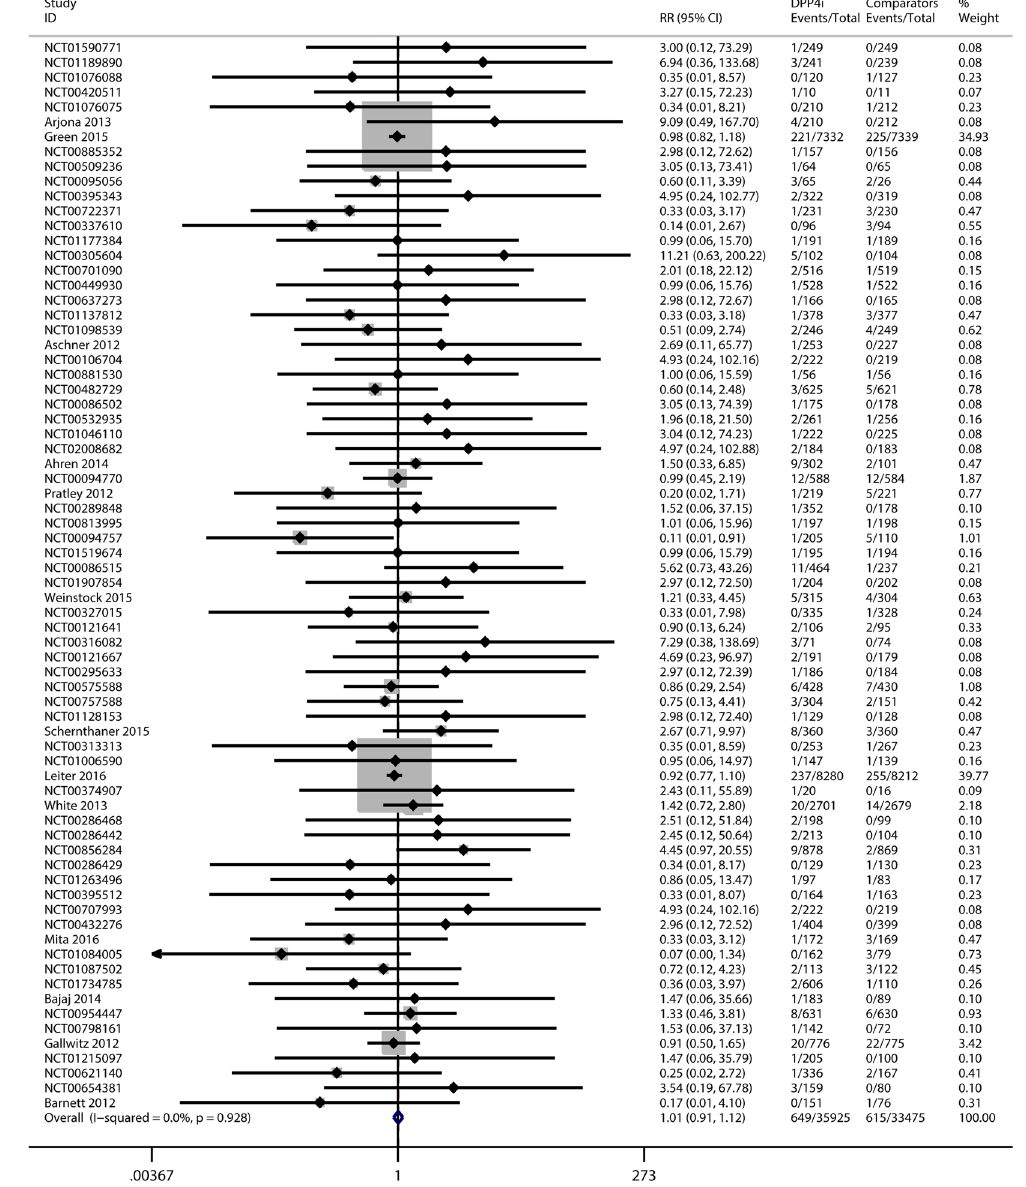
Figure 2. Risk of cancers in patients with type 2 diabetes who were treated with DPP-4 inhibitors versus other drugs. DPP4i: dipeptidyl peptidase-4 inhibitors.